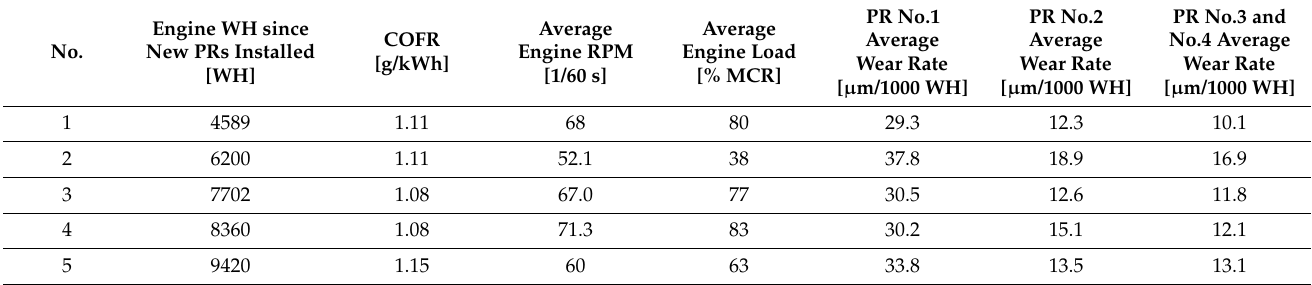
Table 2. Research test results obtained during assessment of Engine No. 2 PRs wear rates.